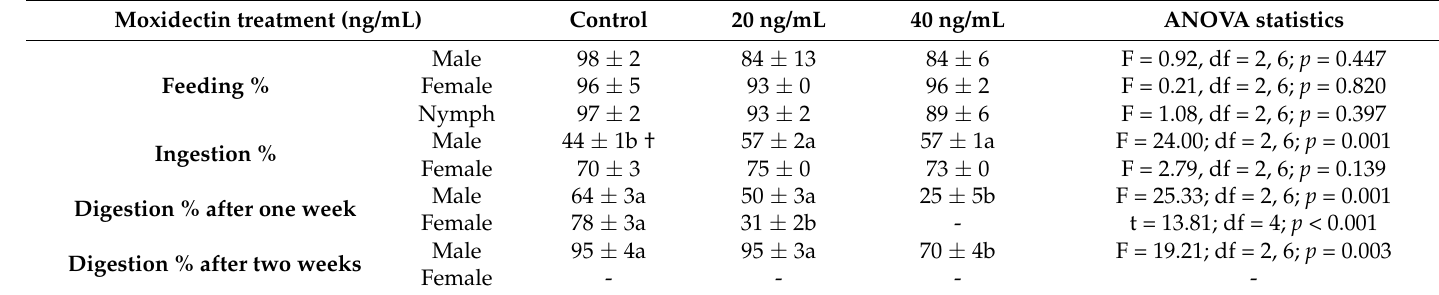
Table 3. Effect of moxidectin on bed bug feeding, ingestion, and